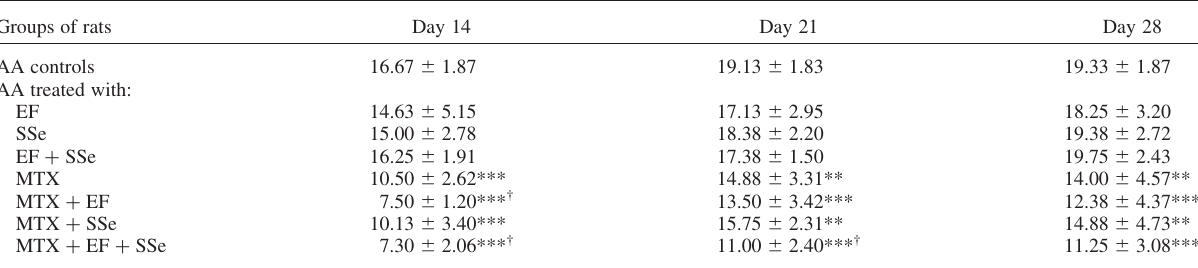
TABLE II The effect of preventive treatment with methotrexate (MTX), E. faecium (EF), selenium (SSe) and their combinations on the arthrogram score in rats with AA Groups of rats